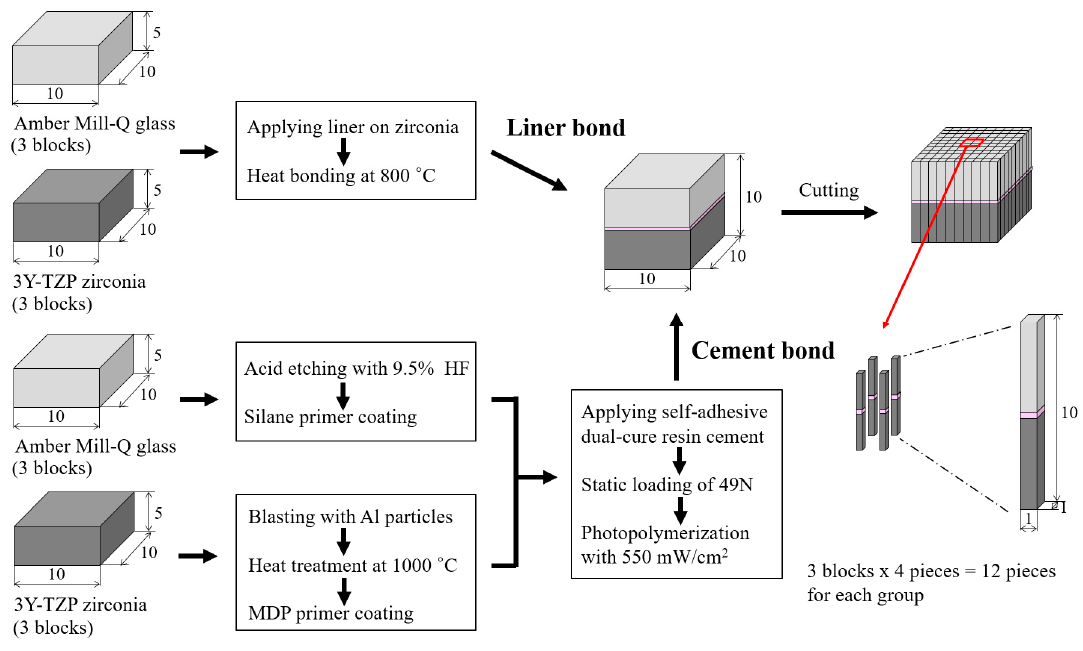
Figure 1. Schematic summary for the preparation process of specimens for the microtensile bond test.